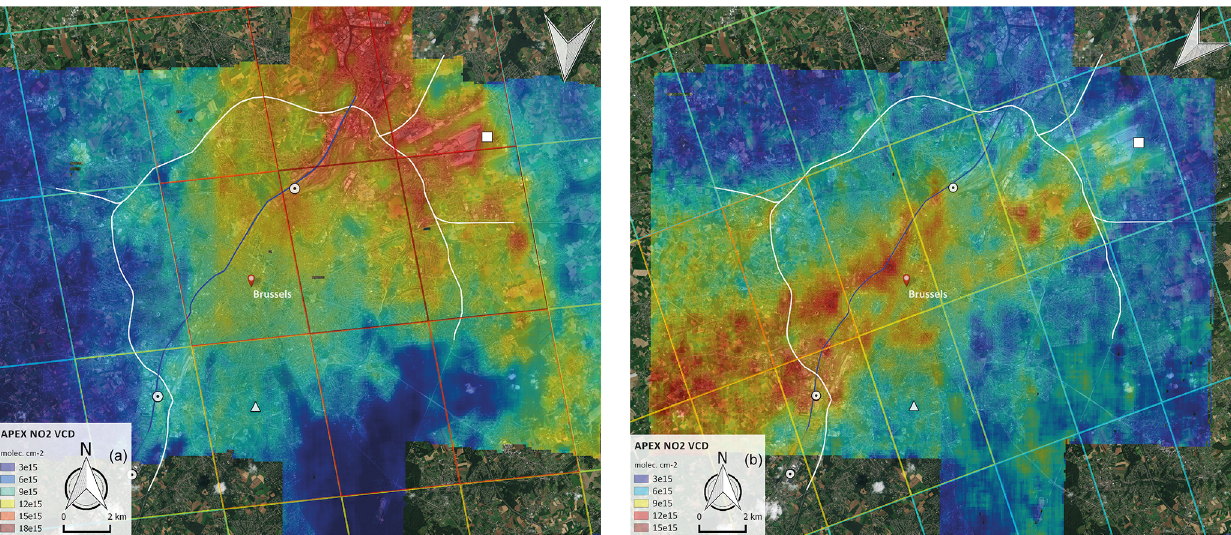
Figure 7. Tropospheric NO 2 VCD grids retrieved over Brussels on (a) 26 June (Flight no. 1) and (b) 28 June (Flight no. 3) 2019. Note that different colour scales were applied in order to optimize the dynamic range of each data set. White dots indicate the point sources, emitting more than 10kg of NO x per hour, according to the emission inventory (2017) of the Belgian Interregional Environment Agency. The white triangle and white square indicate the location of the Uccle MAX-DOAS station and the international airport, respectively. Line sources such as the key highways and city ring road are indicated by white lines. Coinciding TROPOMI tropospheric NO 2 VCD retrievals are overlain as colour-coded polygons. White wind vectors indicate the surface wind, averaged over the APEX acquisition time, as provided in Table 1 (© Google